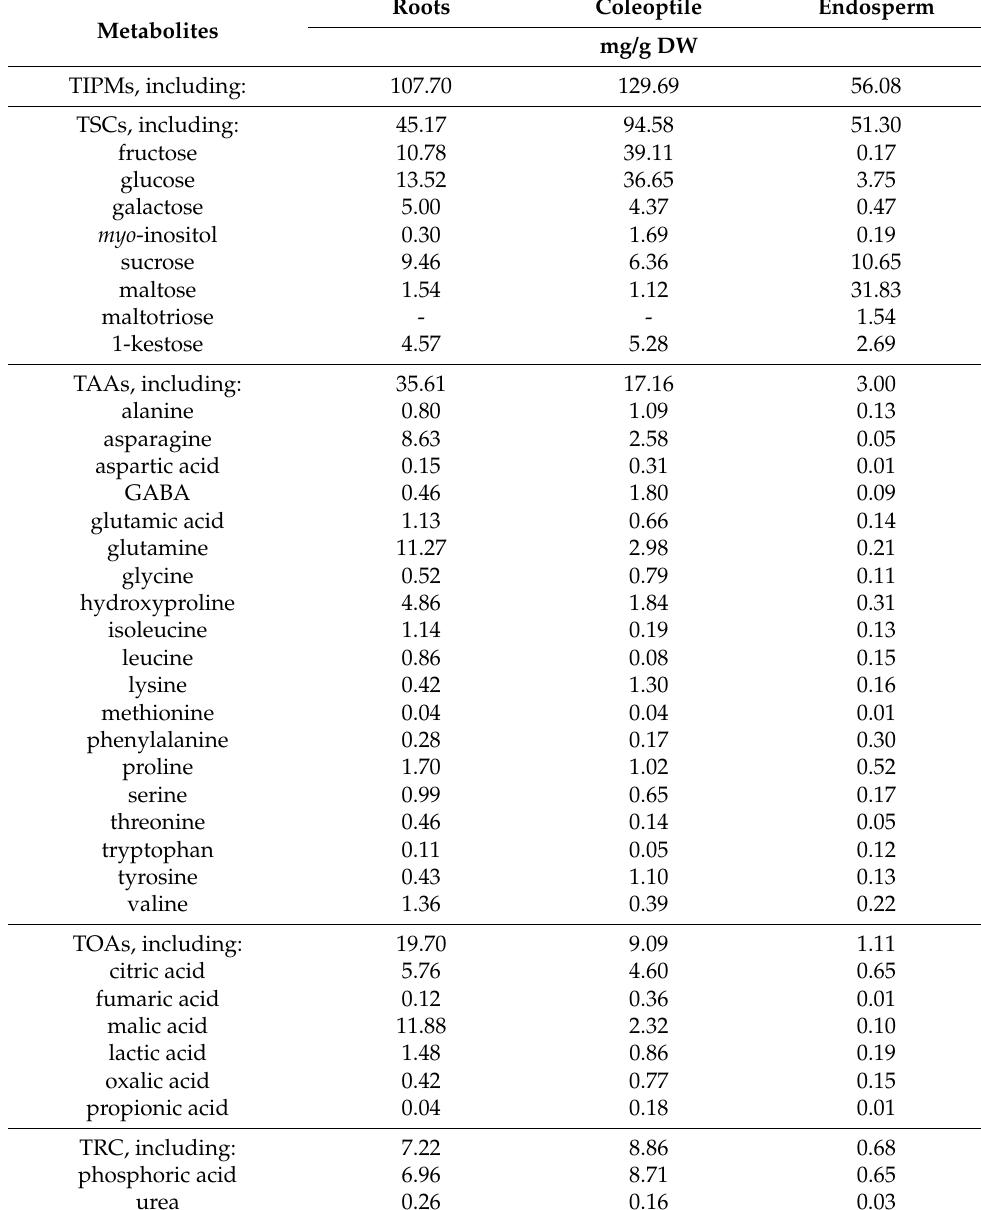
Table 1. The concentration of total identified polar metabolites (TIPMs), total soluble carbohydrates (TSCs), total amino acids (TAAs), total organic acids (TOAs), and total remaining compounds (TRCs) in roots, coleoptile, and endosperm of 3-day-old control seedlings of wheat ( Triticum aestivum L., cv. ‘Ostka Strzelecka’). Roots Metabolites